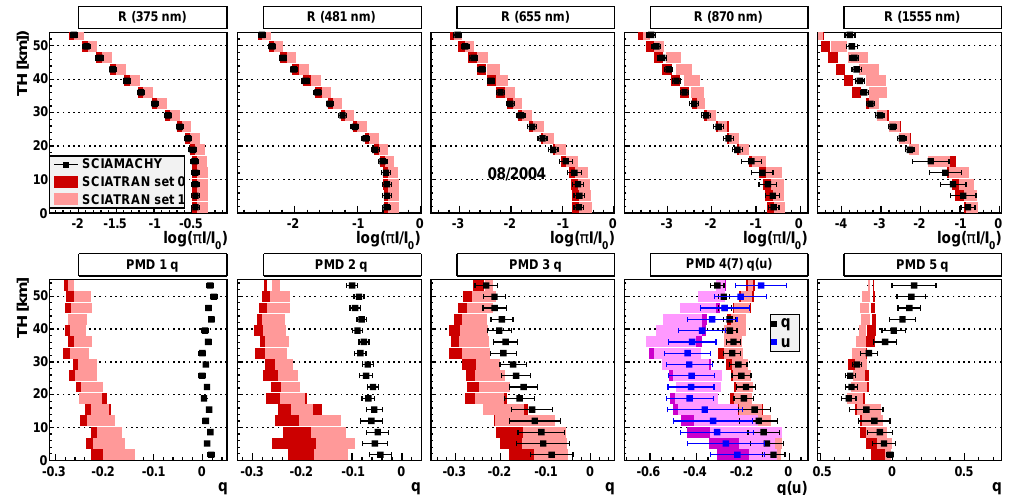
Fig. 2. Reflectance (top panel) and polarization profiles (bottom panel) for SCIAMACHY data (points) and SCIATRAN (boxes, red for q , magenta for u ); the shading indicates different simulation sets (see text for detail). The data set is for the reference state 20 ( θ = 92 ◦ , SZA = 32 ◦ ) in mid-August 2004. The polarization at 850nm (4th panel) contains both q and u values from PMDs 4 (black points) and 7 (blue points),